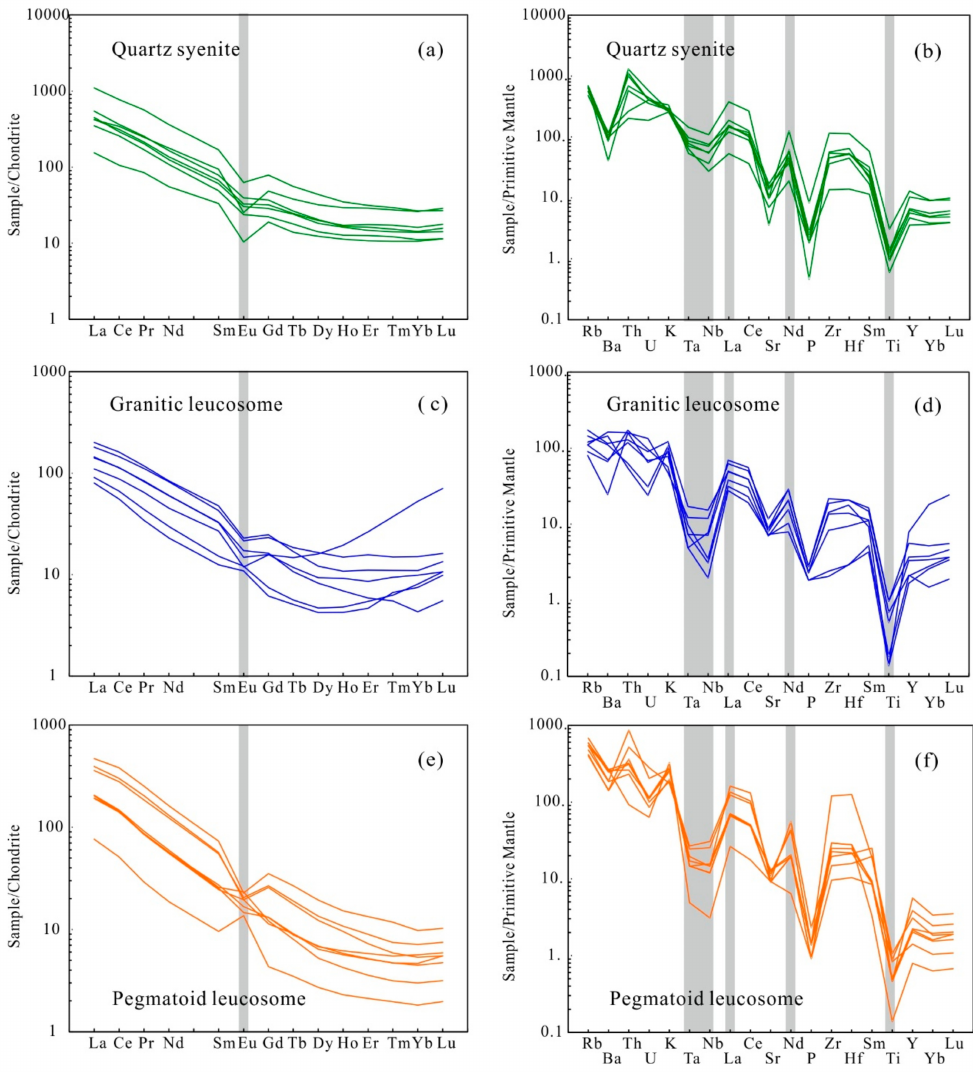
Figure 6. Chondrite-normalized REE patterns ( a , c , e ) and primitive mantle-normalized trace element patterns ( b , d , f ) of quartz syenite and leucosome (chondrite and primitive mantle values are from